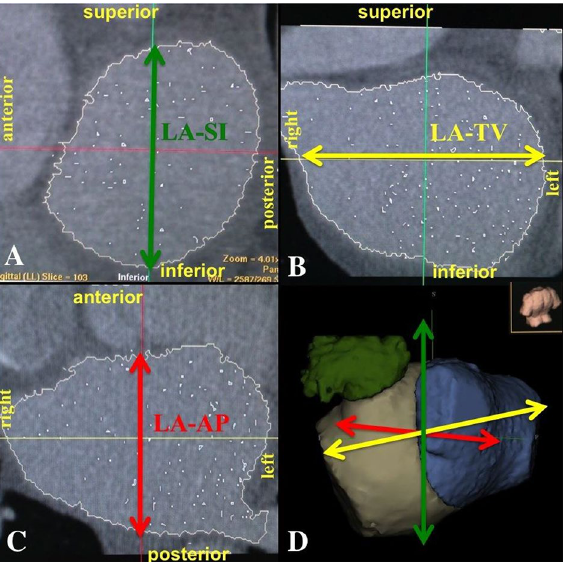
Figure 2. Left atrial diameters measured by Ensite Verismo: ( A ) supero-inferior and ( B ) transversal diameter on a coronal plane, ( C ) antero-posterior on a sagittal plane and ( D ) 3-D LA